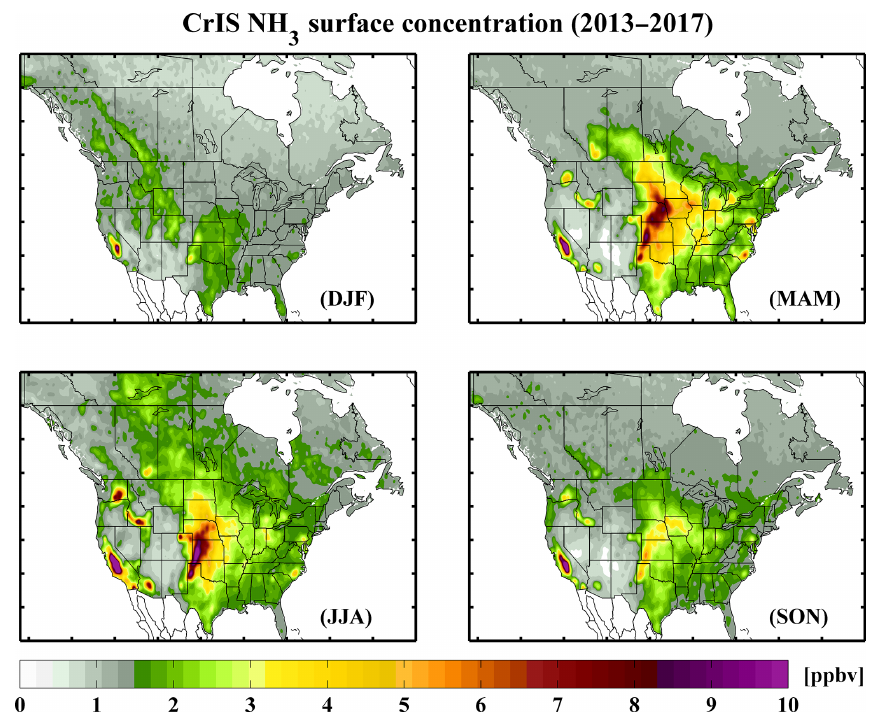
Figure 8. The 5-year mean maps of surface NH 3 over North America during the meteorological winter (December–January–February, DJF),